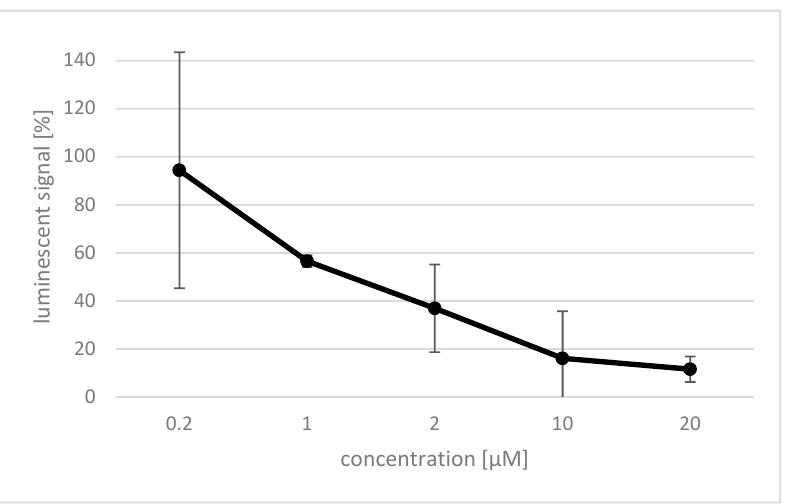
Figure 3. The effect of rosmarinic acid on Nox4 activity is dose-dependent. The amount of reactive oxygen species (ROS) produced by the HEK Nox4 cells and interaction with luminol were detected by luminometric measurement. The percentage of luminescent signal ( y -axis) was established by comparison with an untreated control. Data shown as mean of triplicate ± SD.